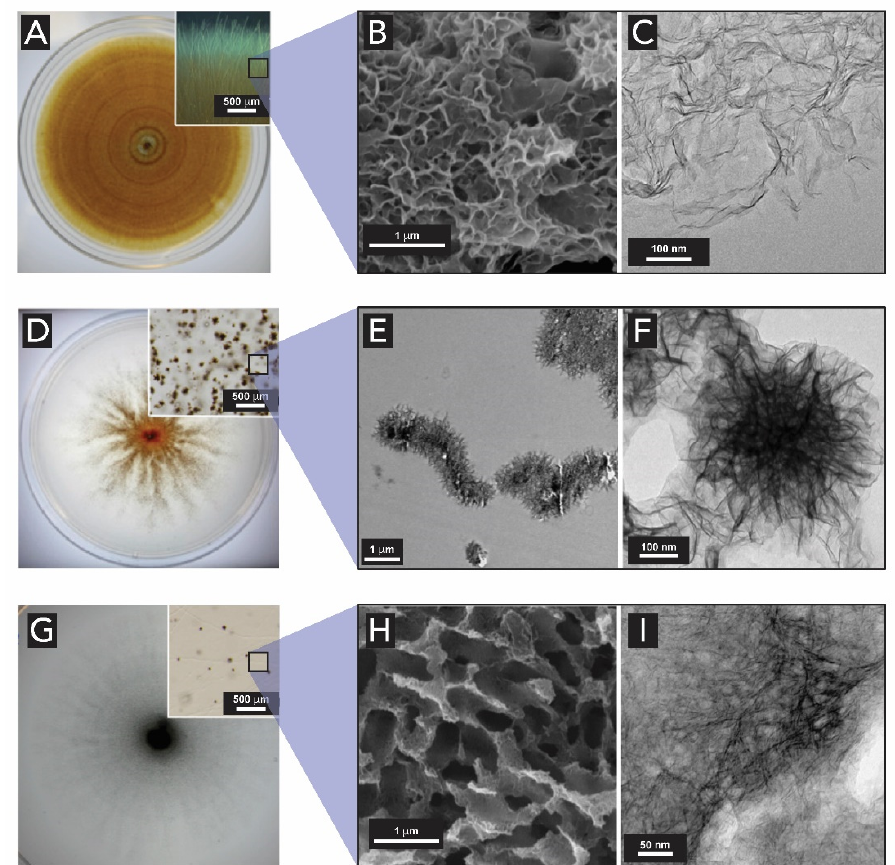
Figure 25. Optical microscopy, SEM, and HR-TEM images of Mn oxides produced by Plectosphaerella cucumerina DS2psM2a2 ( A – C ), Stagonospora sp. SRC1lsM3a ( D – F ) and Acremonium strictum DS1bioAY4a ( G – I ) growing radially outward from the inoculation point in the center of the petri dishes. ( A , D , G ) Optical micrographs of thin sheets of Mn oxides on their surface. ( B , E , H ) SEM images of the Mn oxides particles produced by the fungi. ( C , F , I ) HR-TEM images showing the morphology of Mn oxides. Adapted from [185] with permission from